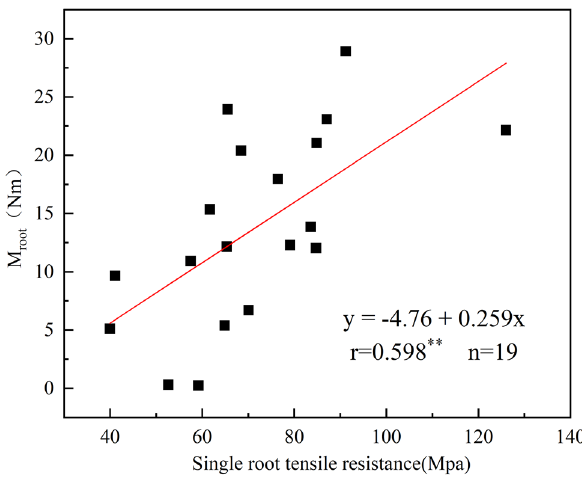
Figure 4. The root failure moment of force was affected by single root tensile resistance. **Statistically significant at 0.01 probability level.